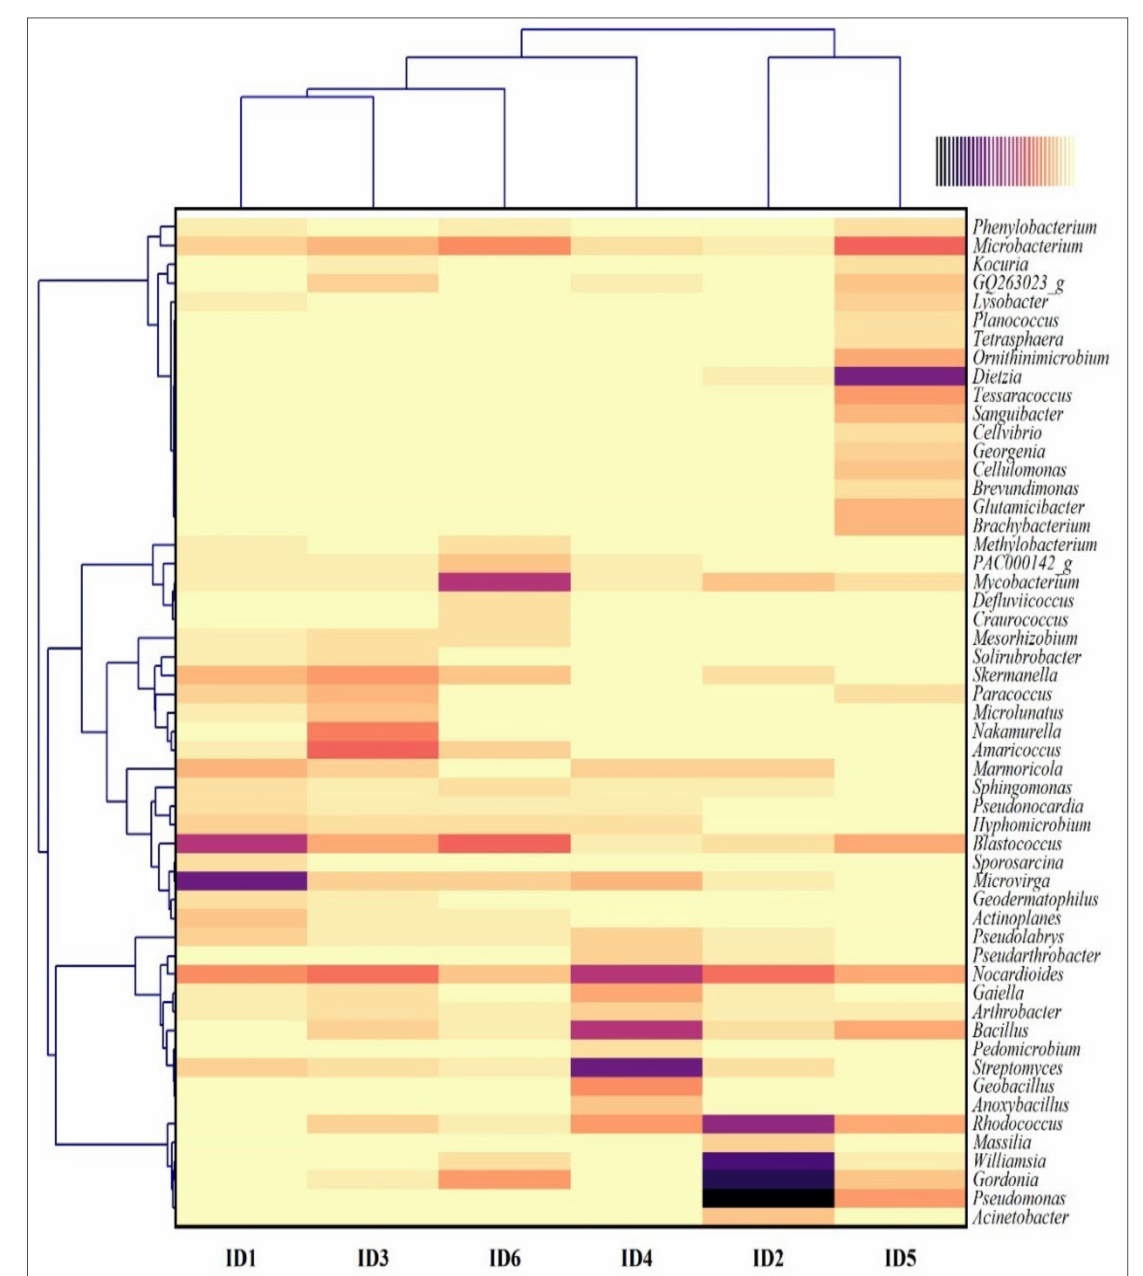
Figure 2. Heat map showing the distributive abundance of diverse bacterial genera in the illegal dumping